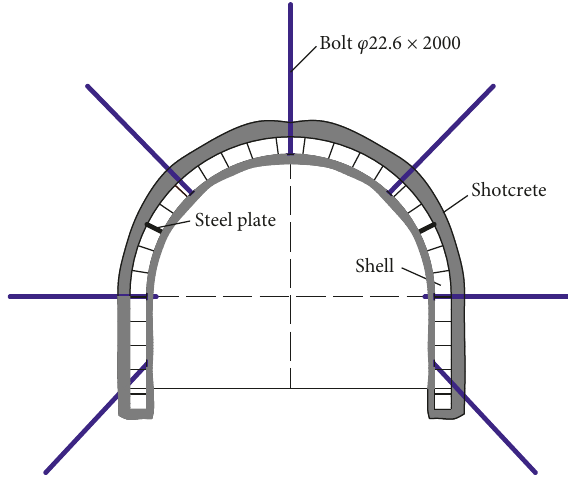
Figure 3: Structure of the new support